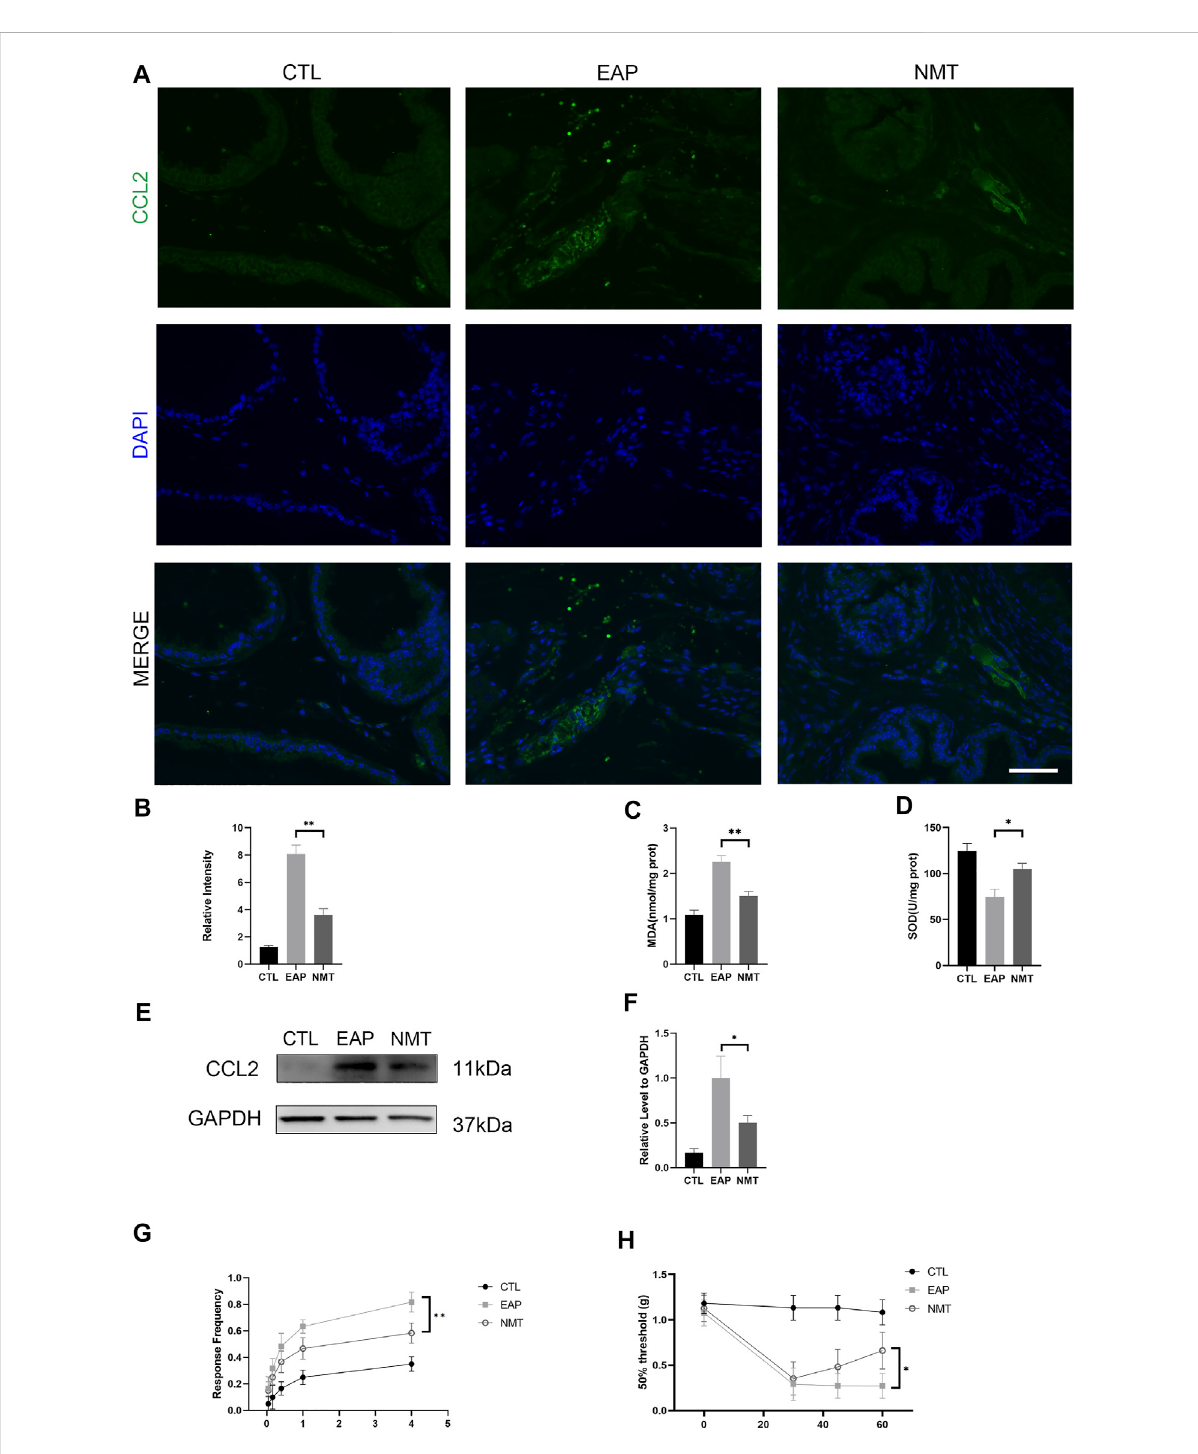
FIGURE 4 PelvicpainreliefandoxidativestressreductioninmicewithCP/CPPSafterNingmitaitreatment. (A) Immuno fl uorescenceexperimentsshowing the expression of the pain-related factor CCL2. Scale bar = 50 μ m. (B) Immuno fl uorescence experiments showing the relative intensity in the CTL, EAP, and NMT groups. n = 6. CTL = control; EAP = experimental autoimmune prostatitis mice; NMT: Ningmitai-treated mice. (C – D) The activities of SOD and MDA in theCTL, EAP, and NMT groups were measured by kits. n = 6. (E – F) Westernblotting analysis of CCL2 and GAPDH expressions as well as statistical graphs of the results in the CTL, EAP, and NMT groups n = 6. (G) Von Frey fi lament response frequency test in the CTL, EAP, and NMT groups n = 6. (H) The Von Frey fi lament up and down test revealed a 50% threshold between the CTL, EAP, and NMT groups. n = 6. (*: p < 0.05; **: p <